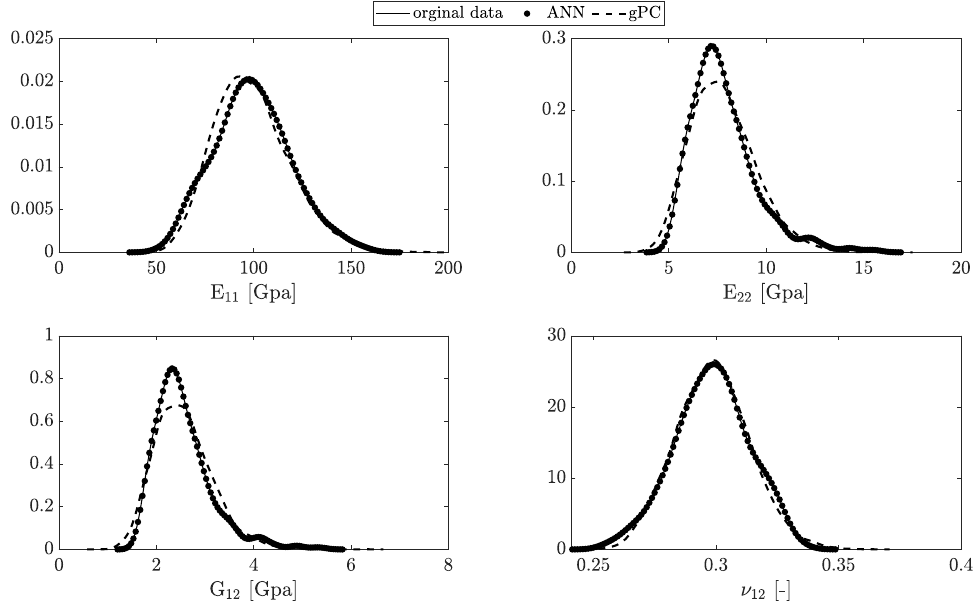
Figure 11. The PDF of the elastic parameters estimated from the ANN model and gPC